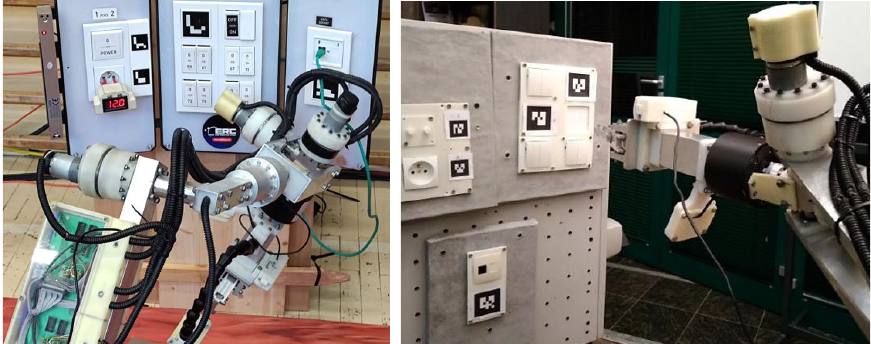
Figure 2. Test panel with ARTag